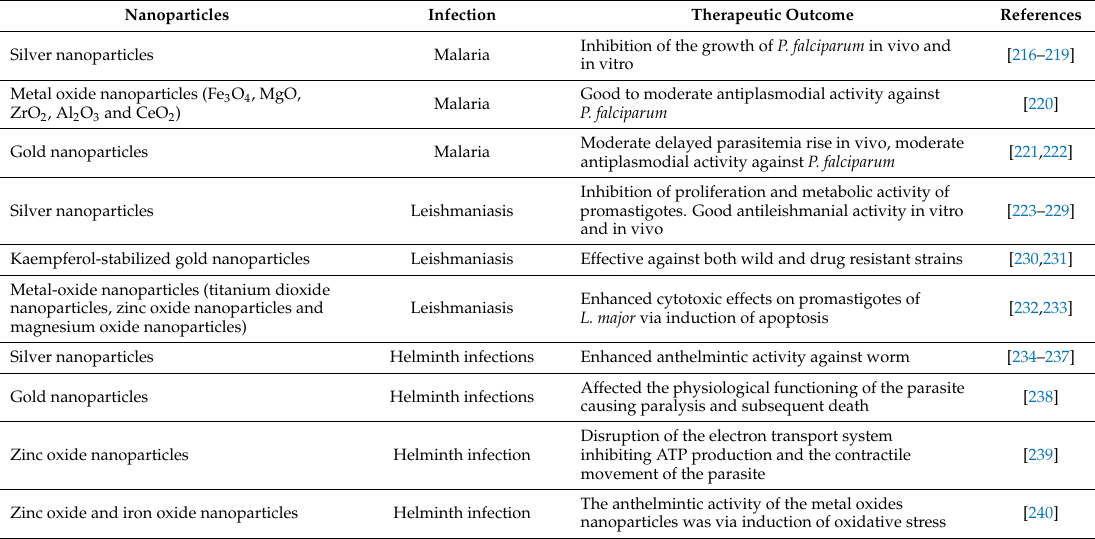
Table 6. Metal-based nanoparticles for the treatment of parasitic